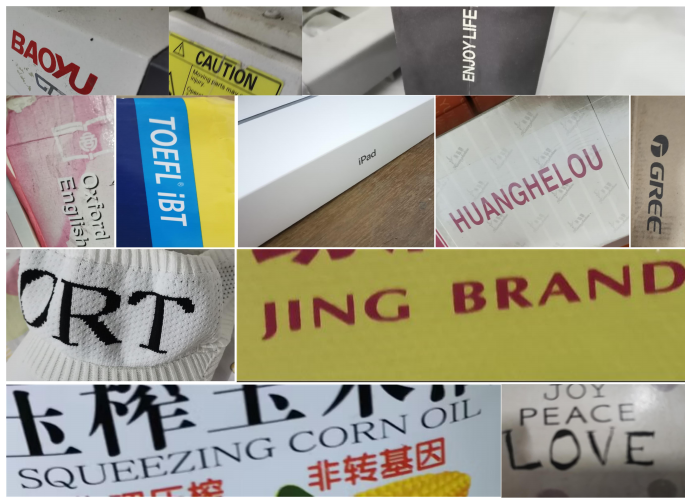
Figure 8. Data distribution of DEC potential space. Table 1. Description of the